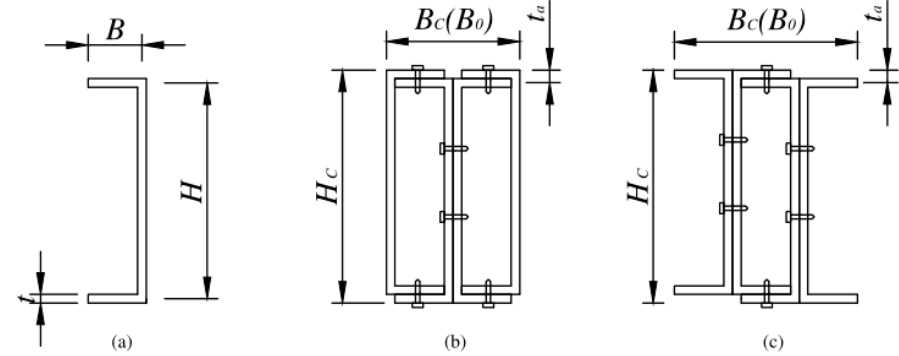
Figure 1. Schematic of members and specimens. ( a ) U-shaped CFS; ( b ) B4 cross section; ( c ) K4 cross section (Unit: mm). Table 1. Nominal dimensions of beam specimens.